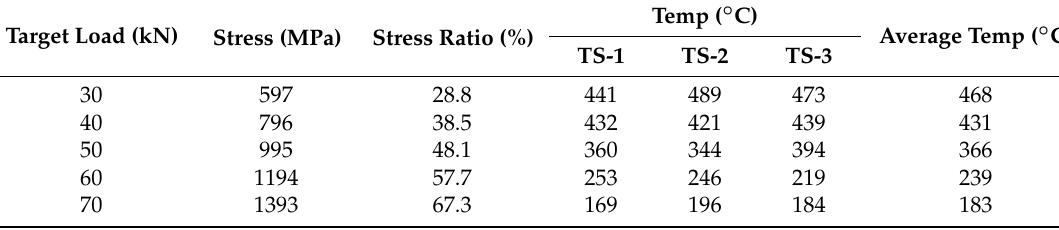
Table 4. Failure temperatures of CFRP tendons in transient state tests.